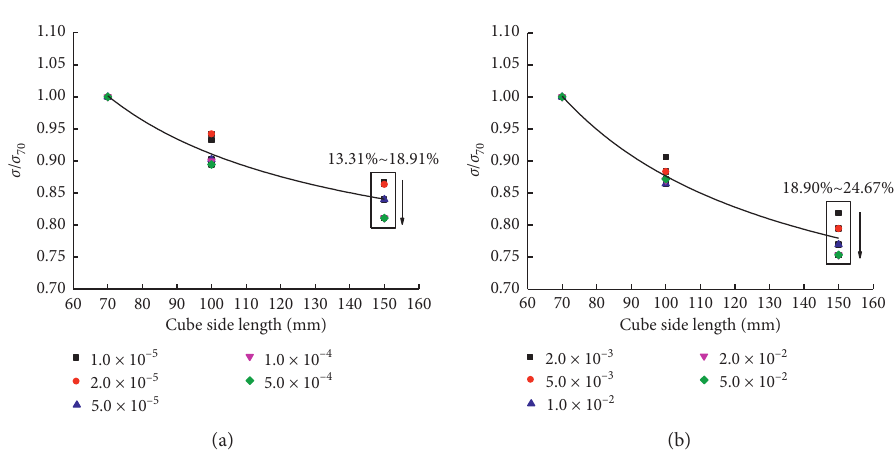
Figure 11: The relationship between the concrete cube length and the variation coefficient of compressive strength.